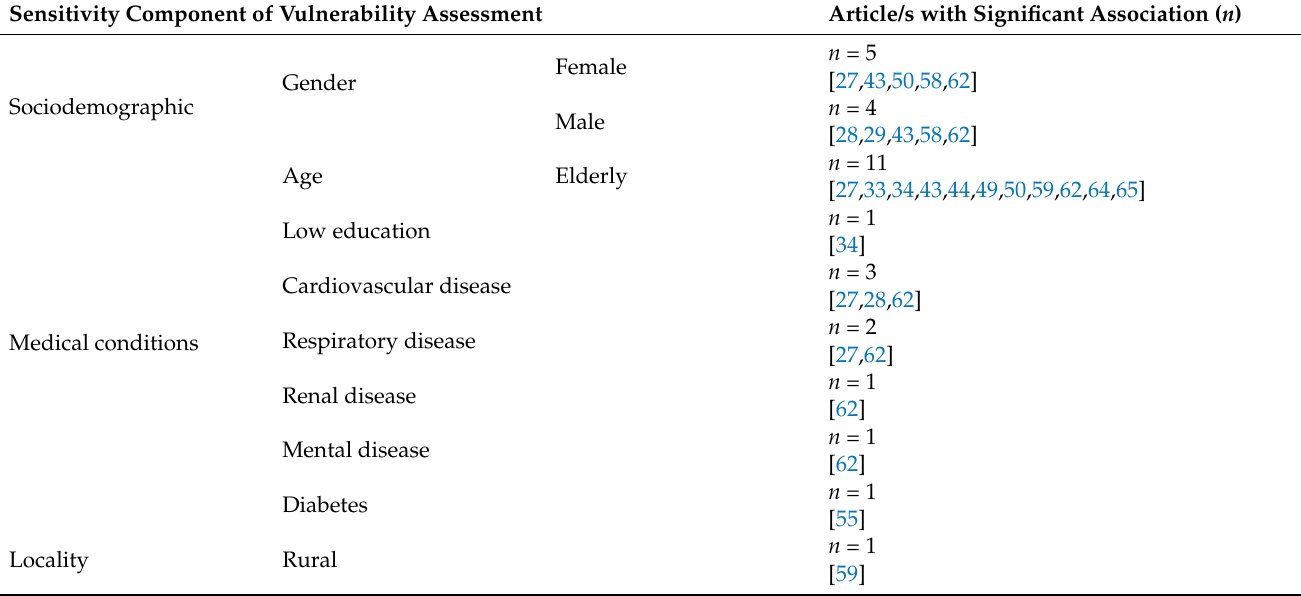
Table 2. Summary of sensitivity component of vulnerability assessment for heat-related mortality.